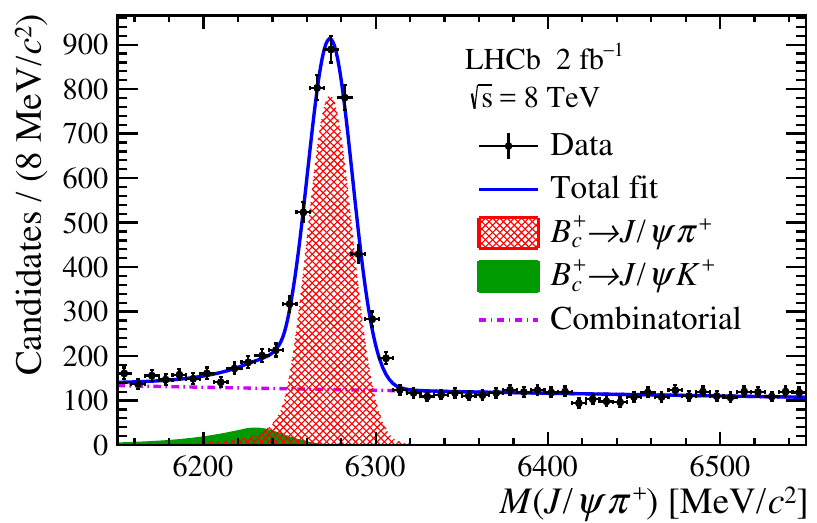
Figure 1. Invariant mass distribution of the selected B + error bars represent the data. The blue solid line is the (cid:12)t to data. The red cross-hatched area shows the signal. The green shaded area represents the B + dash-dotted line is the combinatorial